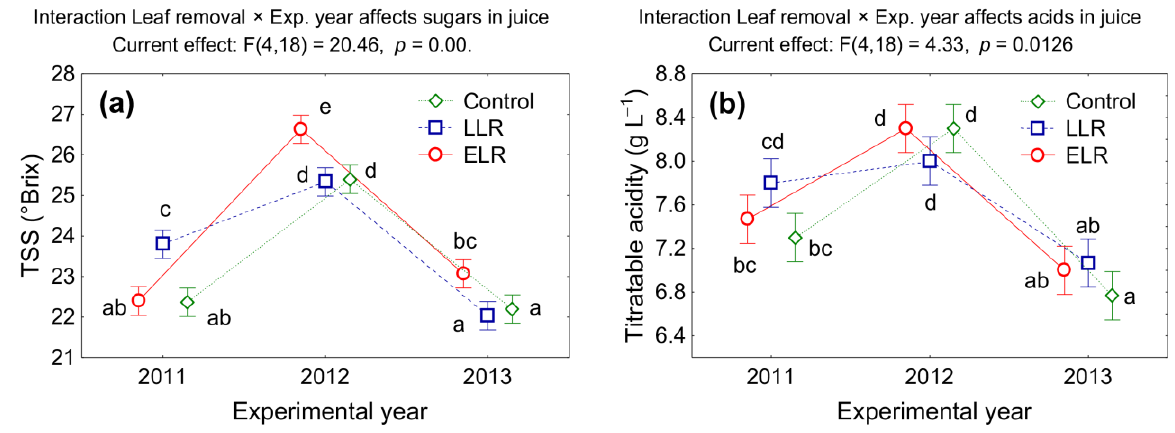
Figure 2. Effect of leaf removal and experimental year on the quality parameters of grape juice. ( a ) Concentration of sugars (total soluble solids (TSS)) (full model R 2 adj. 0.99, F = 104.3, p = 0.000000); ( b ) concentration of titratable acidity (full model R 2 adj. 0.96, F = 29.4, p = 0.000000). Mean values marked with the same letter are not significantly different at α = 0.05. Vertical bars denote 95% confidence